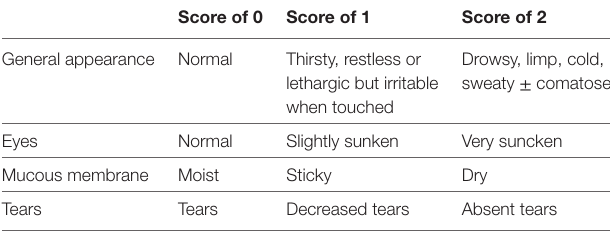
TABLe 11 | Clinical dehydration score for children 1 month to 3 years (54). Score of 0 Score of 1 Score of 2